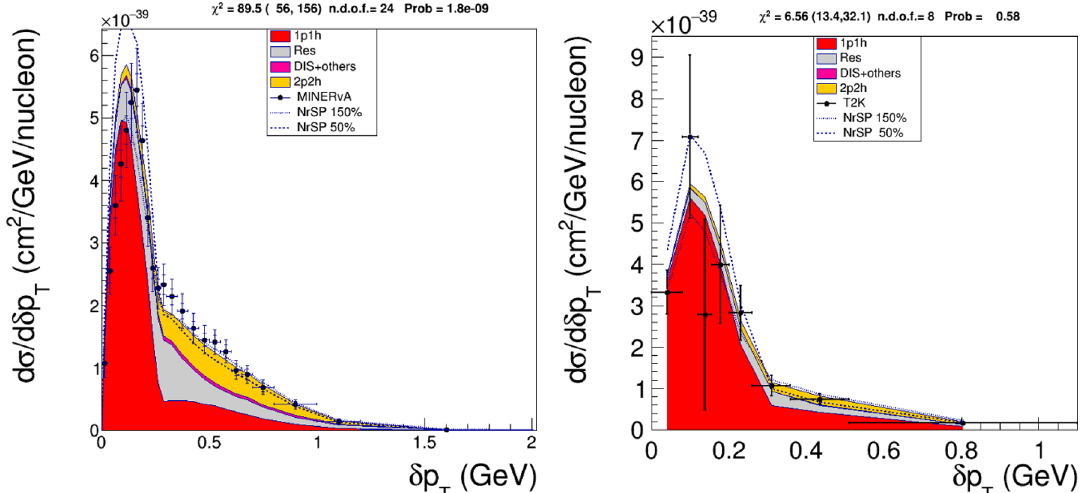
Figure 10 . CC 0 π 1 p MINERvA [15, 19, 20] (left) and T2K [21] (right) distributions for the missing transverse momentum | δ~p . Details of the comparison with NEUT results as in figure T |